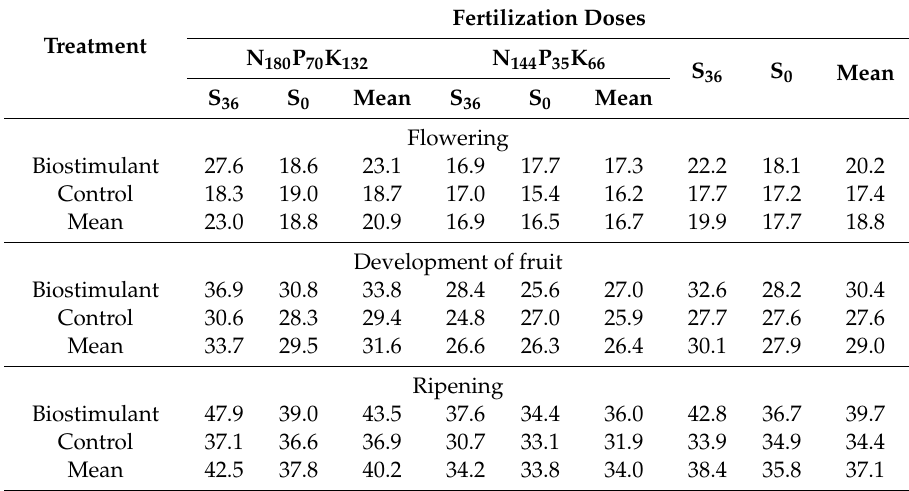
Table 8. Accumulation of K in roots of rapeseed in generative development stages depending